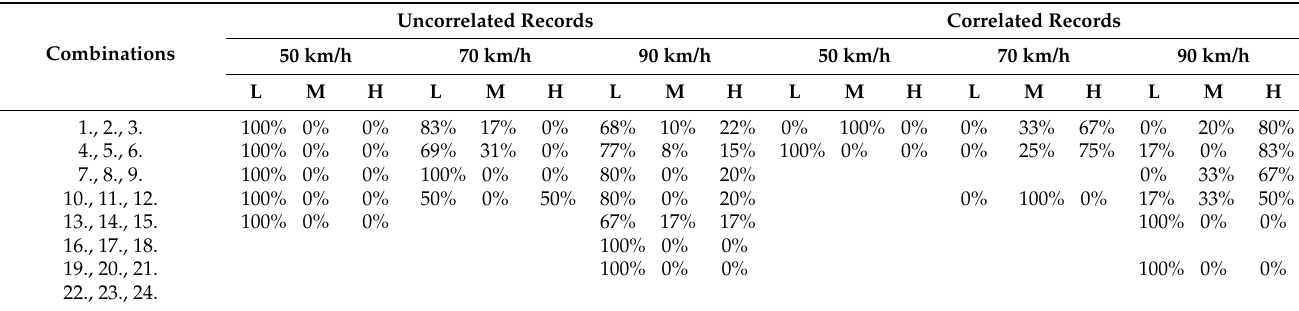
Table 11. Mutual comparison of the probability of each combination for the